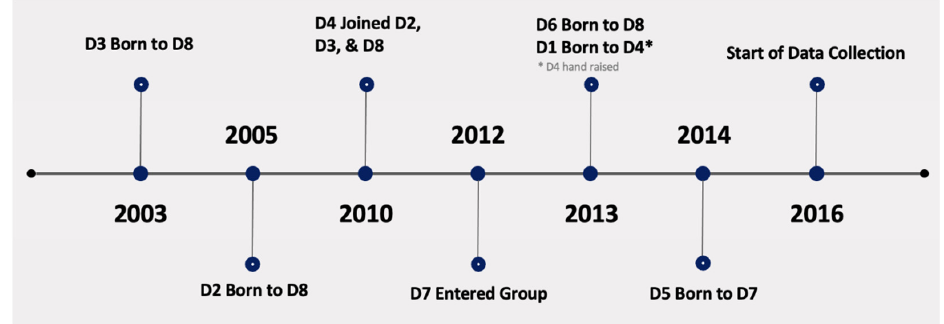
Figure 1. Timeline of dolphins entering and being born into the social group.